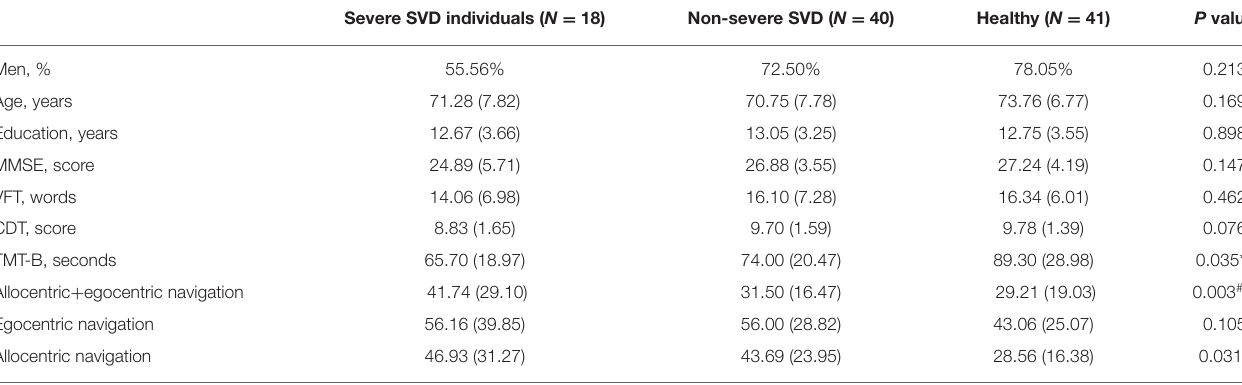
TABLE 1 | Clinical and demographic characteristics and index of spatial navigation performance of the